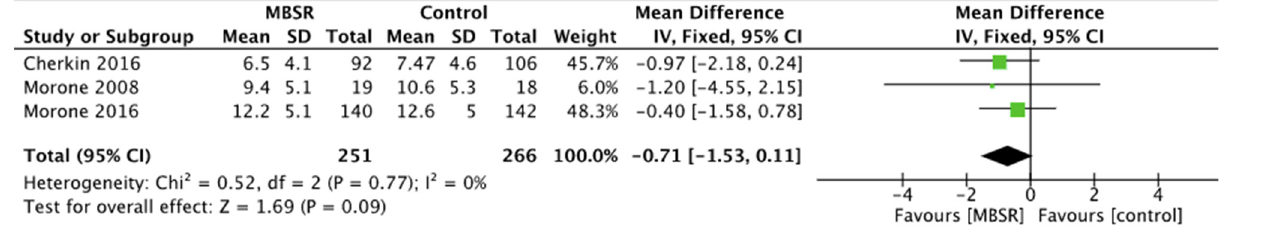
Figure 6. Disability: MBSR versus control.